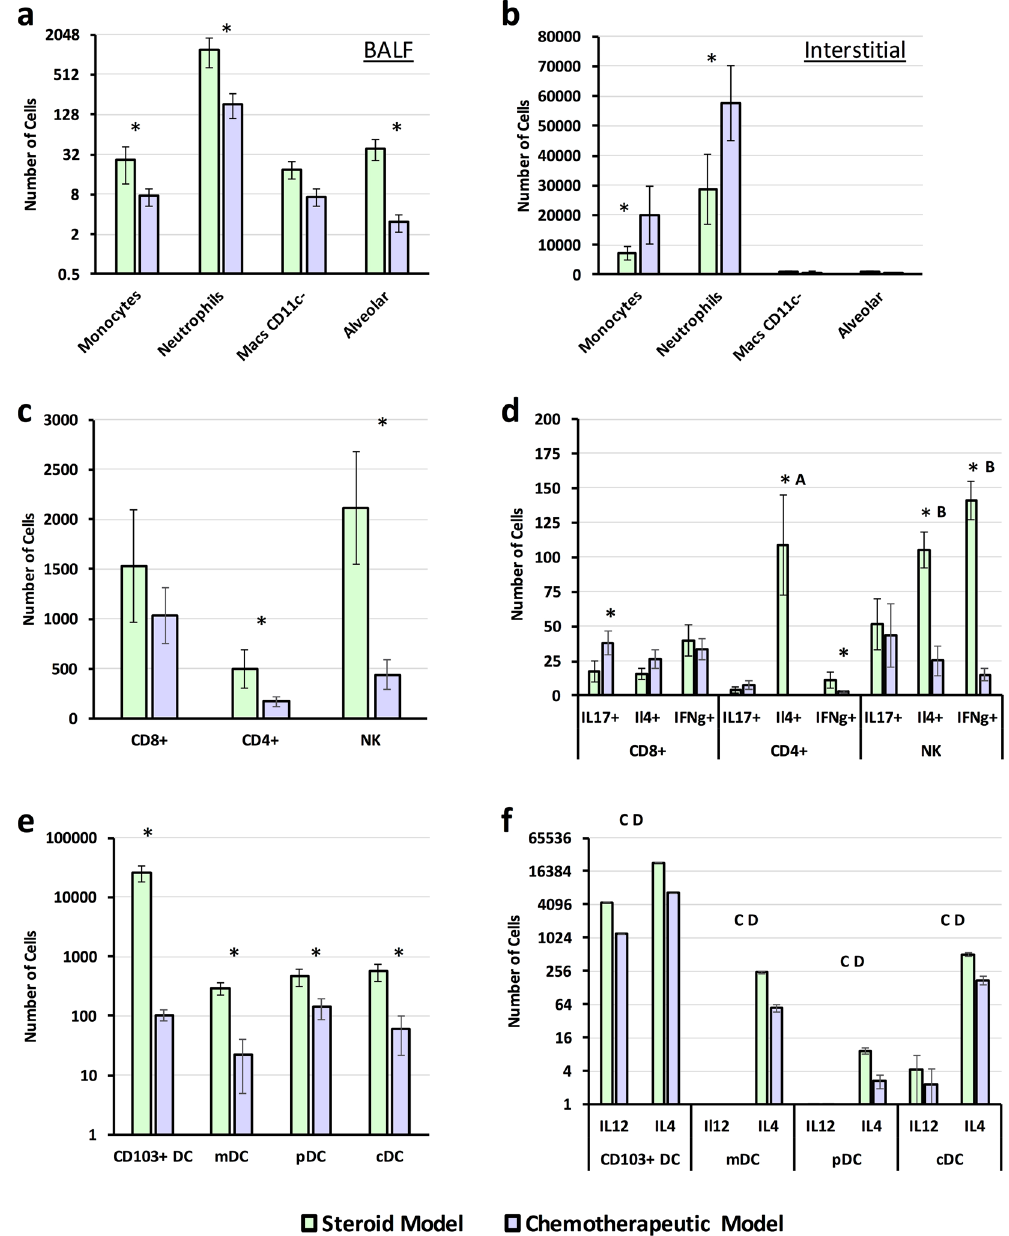
Figure 5. Determination of in vivo leukocyte and intracellular cytokine production. Freshly harvested A. fumigatus conidia (CEA10, 12 × 10 9 ) were delivered via aerosolization to immunosuppressed C57BL/6 mice. Mice in the steroid model were immunosuppressed via subcutaneous injection of cortisone acetate, while mice in the chemotherapeutic model were immunosuppressed via subcutaneous injection of cortisone acetate and intraperitoneal injection of cyclophosphamide three days prior to inoculation. Leukocyte populations and counts were determined from ( a ) bronchoalveolar lavage fluid (BALF) and ( b – f ) lung tissue. Cell counts were determined for ( c ) CD4 + , CD8 + , and NK cell populations and ( d ) for positive intracellular staining of IL-17, IL-4, or IFN- γ . Cells counts were also determined ( e ) CD103 + , monocytoid (mDC), plasmocytoid (pDC), and conventional (cDC) dendritic cells and for ( f ) positive intracellular staining of IL-12 and IL-4. Statistical significance was determined use the student t-test. Statistical significance (p < 0.05) between the two models for a given cell type is indicated by an asterisk. Statistical significance via Duncan’s multiple range test (p < 0.05) for CD4 + T cells stained positive IL-4, IL-17, and IFN- γ is indicated with ‘A’ (steroid model). Statistical significance via Duncan’s multiple range test (p < 0.05) for NK cells stained positive IL-4, IL-17, and IFN- γ is indicated with ‘B’ (steroid model). Statistical significance (p < 0.05) between a given dendritic cell population for count of cells positive for IL-12 versus IL-4 production is indicated with an ‘C’ in the steroid model, and a ‘D’ for the chemotherapeutic model. All experiments were run in independent replicates, n =